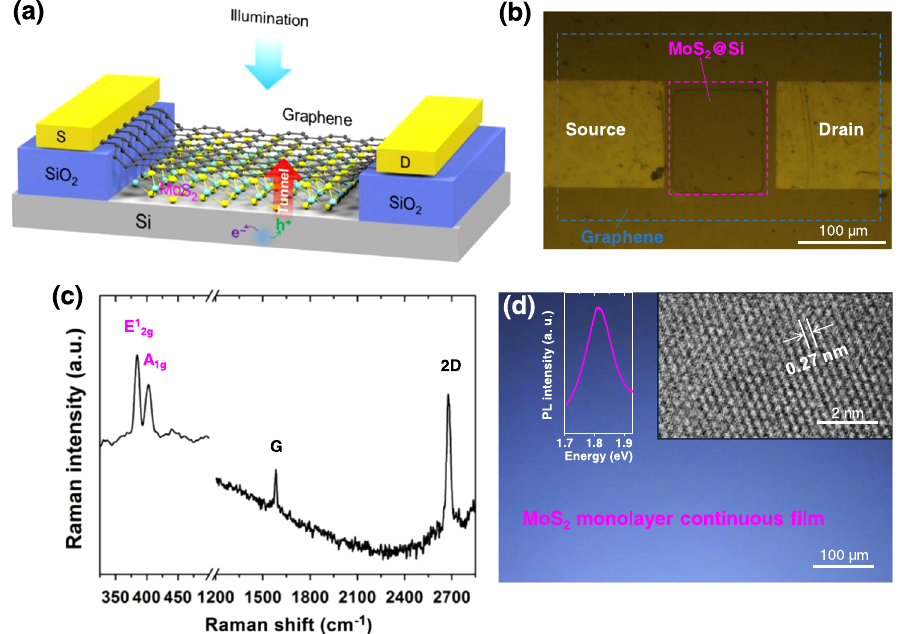
Fig. 1 Schematic diagram and characterizations of the hybrid graphene photoconductor. a Schematic and b top view optical image of the device. c Raman spectra taken in the area within the violet dashed rectangle in ( b ). d Optical image of monolayer MoS 2 fi lm before transfer. Upper left inset : a typical PL spectrum of monolayer MoS 2 fi lm with the peak at 1.82 eV. Upper right inset : HRTEM image of the MoS 2 fi